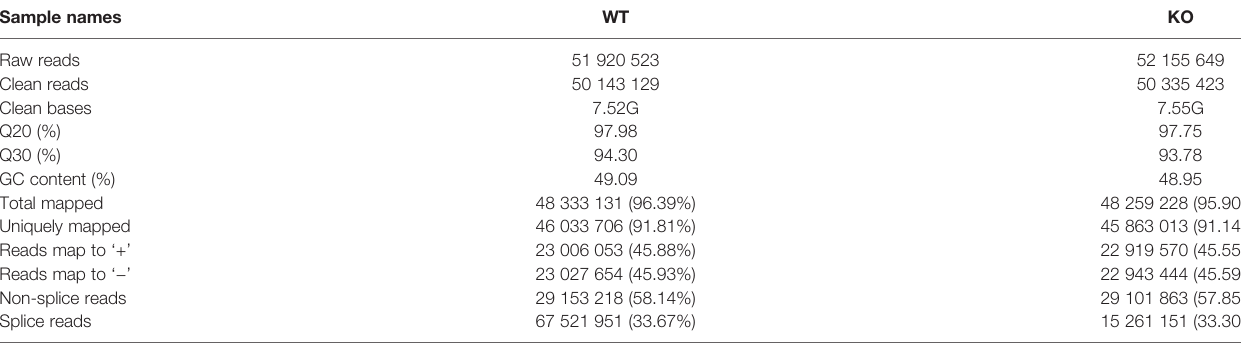
TABLE 2 | Principal features of tags in two libraries and data of sequencing reads mapping to the reference genome. Sample